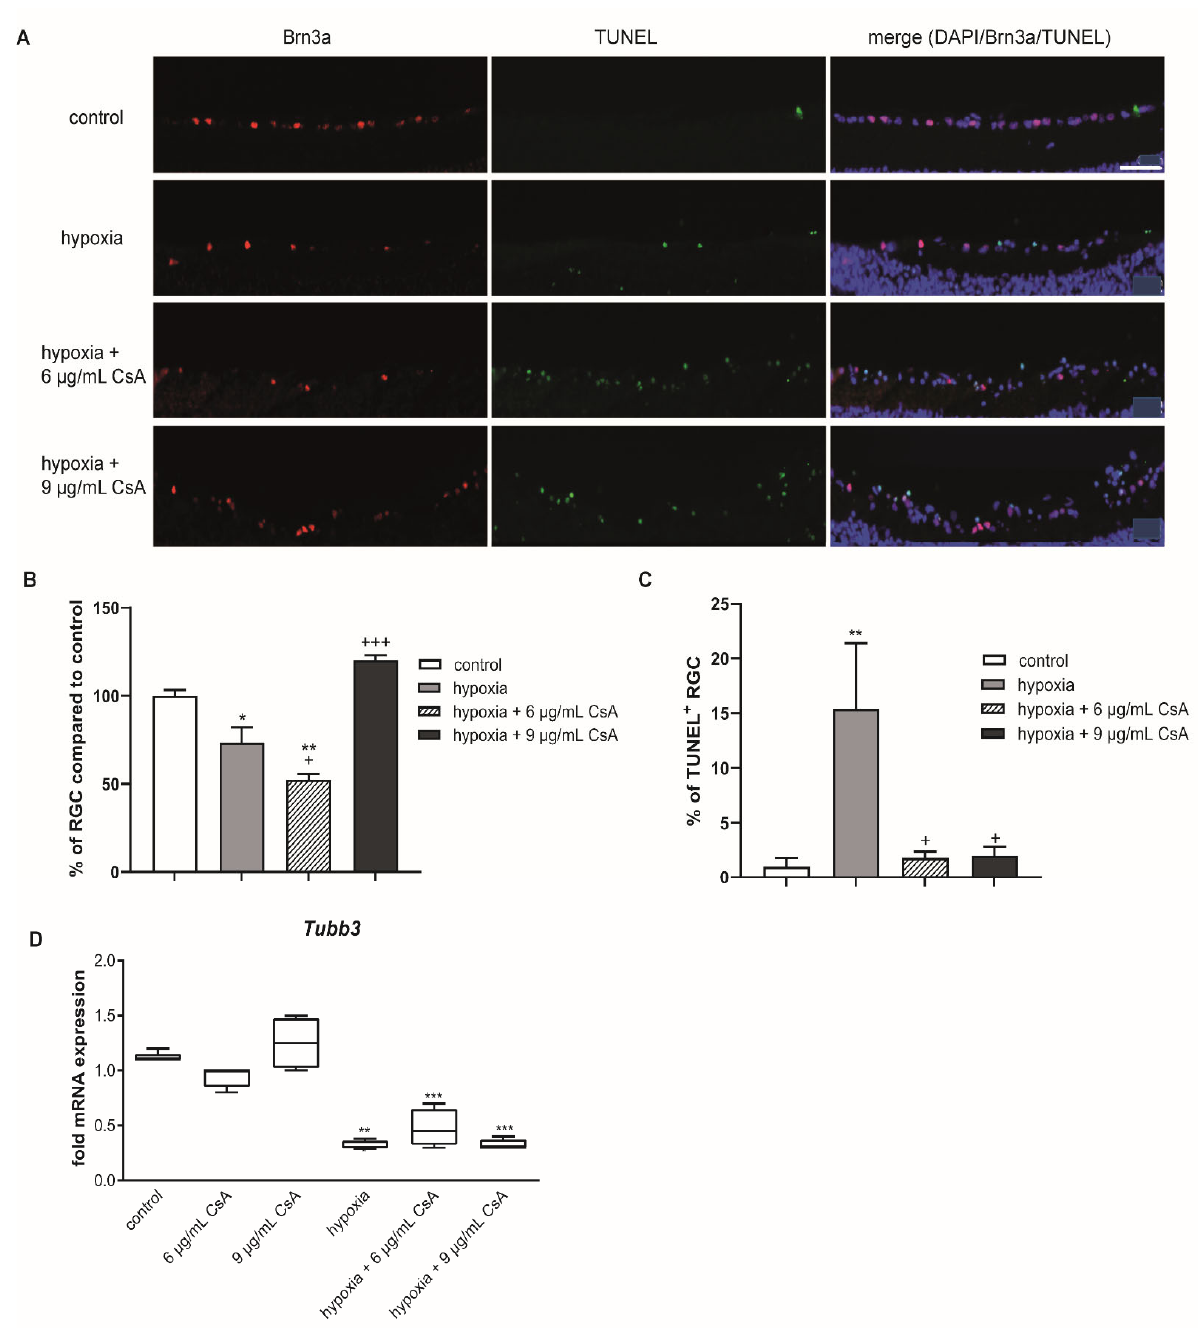
Figure 4. CsA treatment rescued RGCs from hypoxia ‐ induced apoptosis. ( A ) Representative pictures of the corresponding sections. Sections were triple stained for DAPI (purple), Brn3a + (red) and TUNEL + (green) cells. Scale bar indicates 50 μ m. ( B ) Bar graphs represent the percentage of RGCs in the GCL after 48 h of cultivation. Hypoxia caused a loss of RGCs, which could be counteracted by treatment with 9 μ g/mL CsA. ( C ) Graphical illustration of TUNEL + RGCs out of the total RGC amount as a percentage. Hypoxia treatment led to a massive increase of TUNEL + RGCs, which was prevented by treatment with 6 or 9 μ g/mL CsA. ( D ) Retinal hypoxia resulted in a significant reduction of neuronal mRNA expression of the RGC marker Tubb3 . CsA treatment with either 6 or 9 μ g/mL could not protect from this loss in neuronal mRNA expression after hypoxia. CsA did not alter neuronal Tubb3 mRNA expression in untreated retinal explants. Data are depicted as mean + SEM. Significances are indicated as * with respect to the control condition and as + with respect to the ischemic treatment using the following significance levels: +/* p < 0.05, ** p < 0.01, +++/*** p <